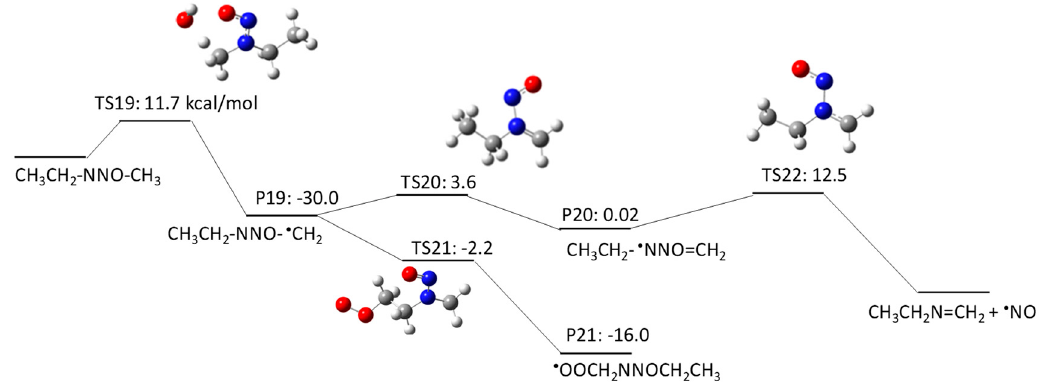
Figure 6. Free energy profile for pathway 2–3 of the HO • -induced reaction pathways for NMEA via H abstraction from a C–H bond of the terminal CH 3 functional group adjacent to the N–NO functional group. The numbers (kcal/mol) are the free energy of activation for the TS and free energy of reaction for the P relative to the corresponding reactant.